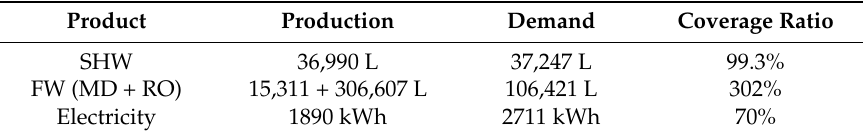
Table 6. Allowed productions and covered demands in the base